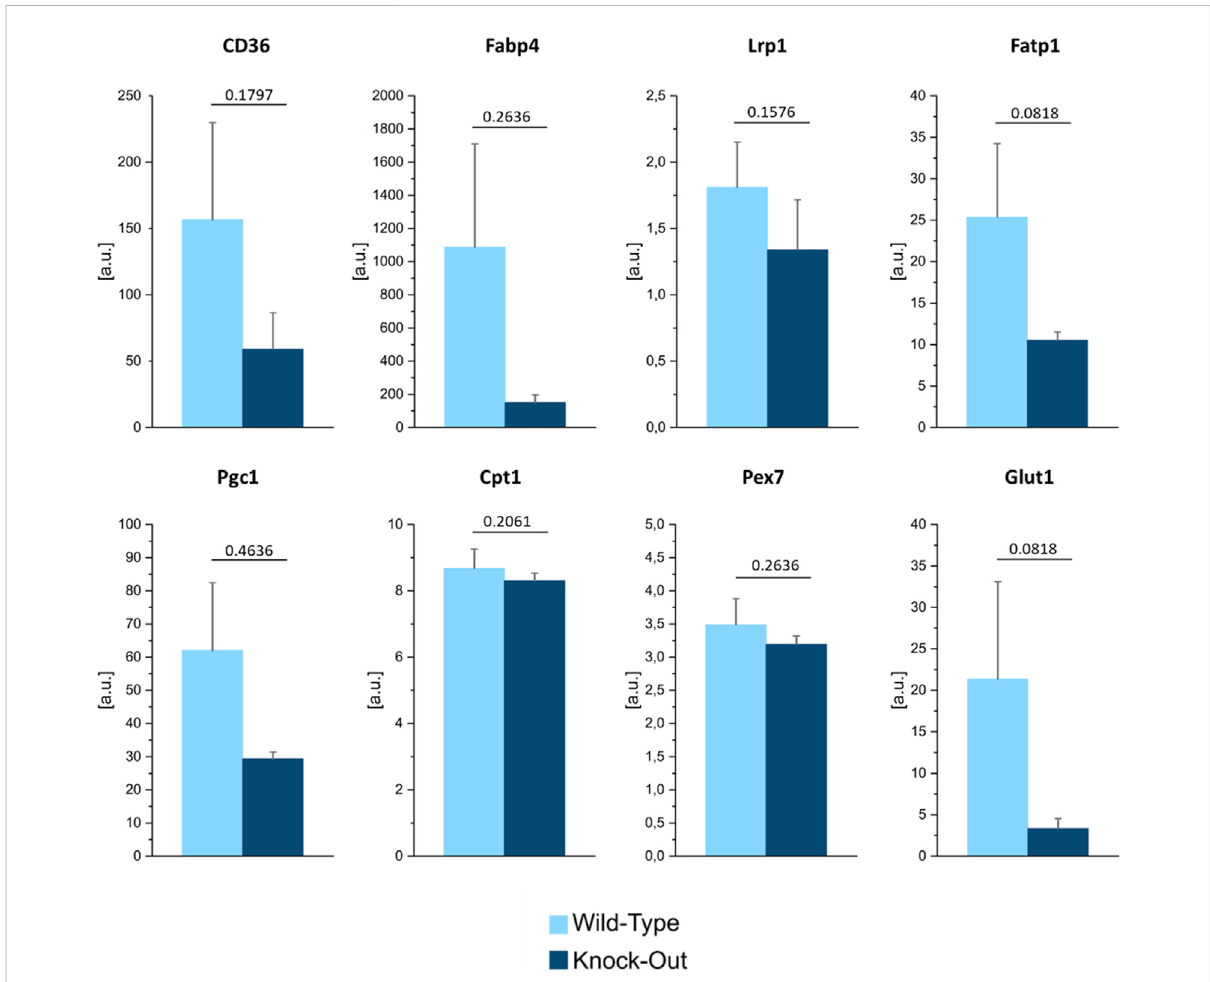
FIGURE 8 Gene expression analysis of selected genes relevant for lipid transport, uptake, and metabolism, in the fl ushed bone of WT and Dpp3 KO mice ( n = 4 WT and 7 KO). Statistical analysis was performed using Mann Whitney test; p values are indicated above each graph.